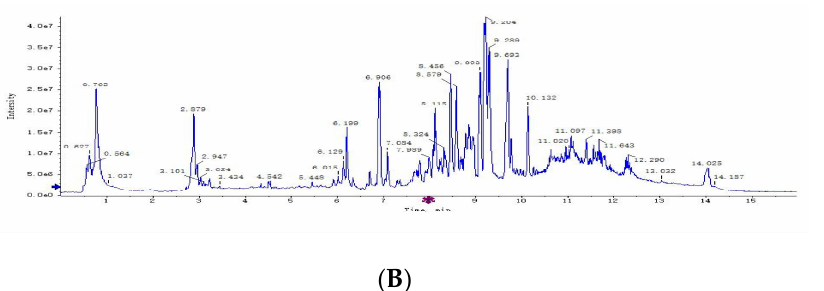
Figure 1. Overlap of the total ion chromatograms of the QC sample in the positive ( A ) and negative ( B ) ion modes.